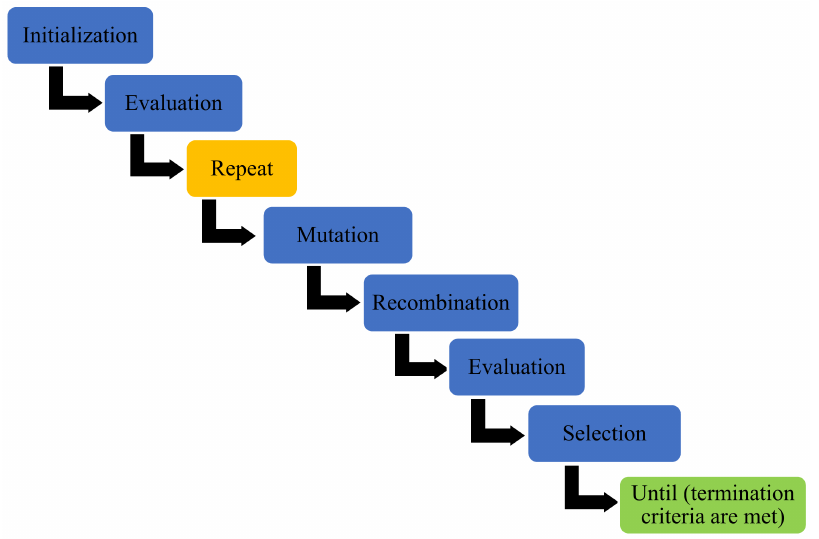
Figure 8. DEO sequential